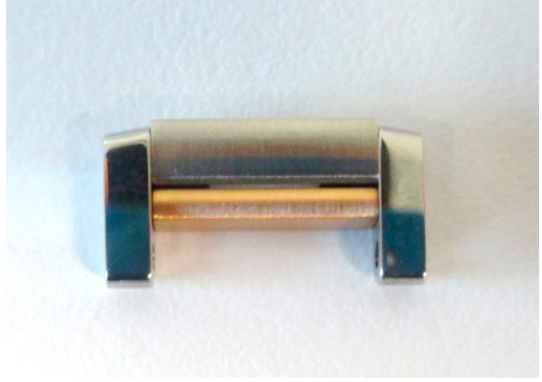
Figure 4. Link, steel-gold assembly with pins.